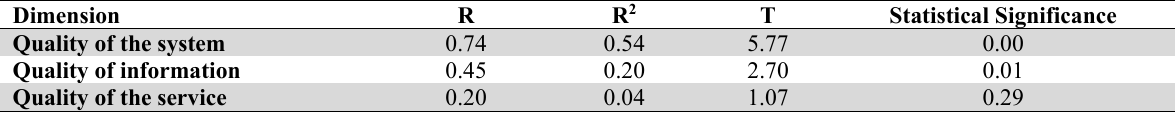
Results of applying the Uni-Linear Regression to study the effect of each independent variable on the dependent variable Dimension